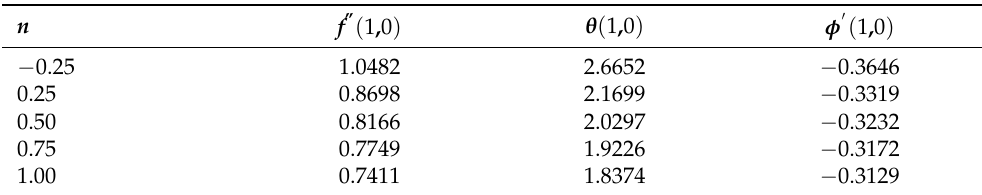
Table 5. Solutions of f (cid:48)(cid:48) ( 1,0 ) , θ ( 1,0 ) , and φ (cid:48) ( 1,0 ) for various values of n at Sc = 1.0, N = 1.0, γ = 2.01,